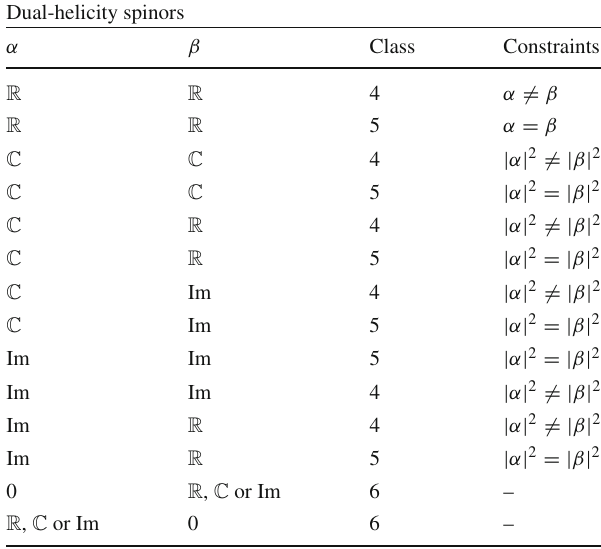
Table 2 The phases constraints to classify singular spinors Dual-helicity